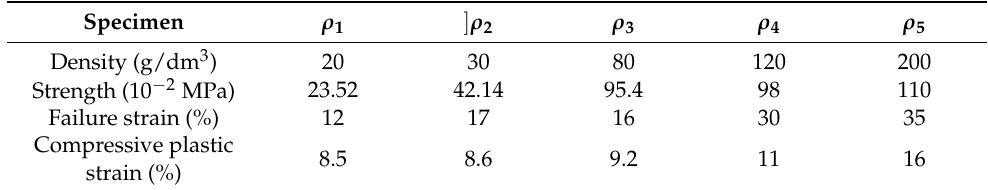
Figure 5. Testing machines ( a ) Zwick/Roell Z005, ( b ) Q-test 10 material testing system (MTS). Table 1. Material properties of the